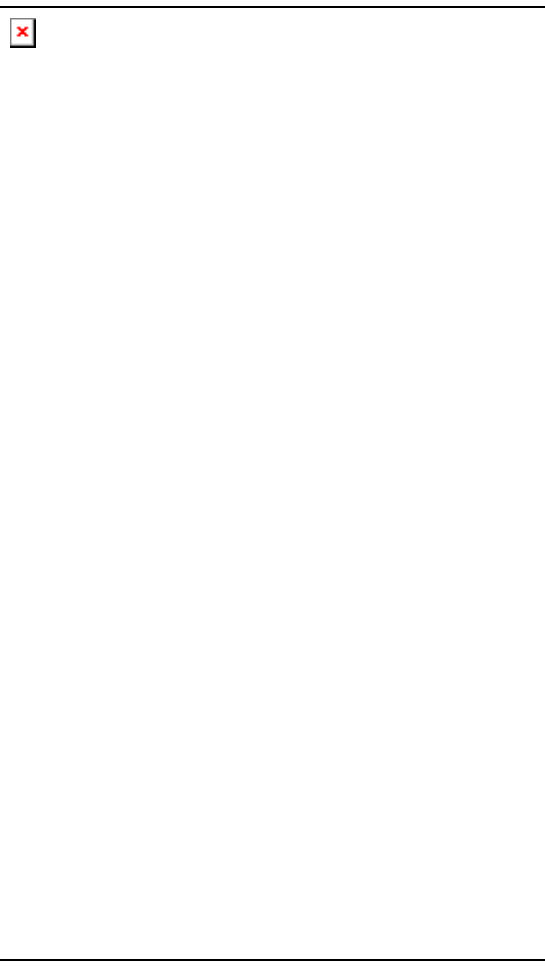
Figure 4: Glass fin in the façade, indicated are the stresses caused by the max. wind load, perpendicular to the